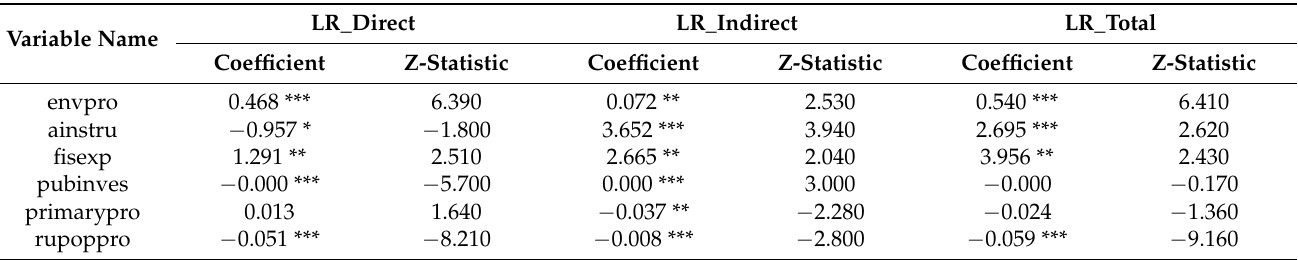
Table 3. Calculation results of direct and indirect